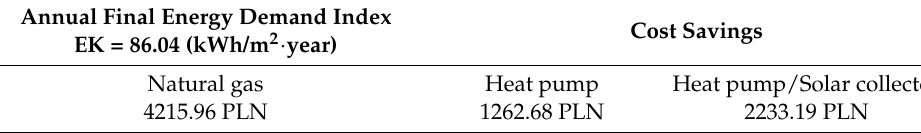
Table 6. Value of annual heating